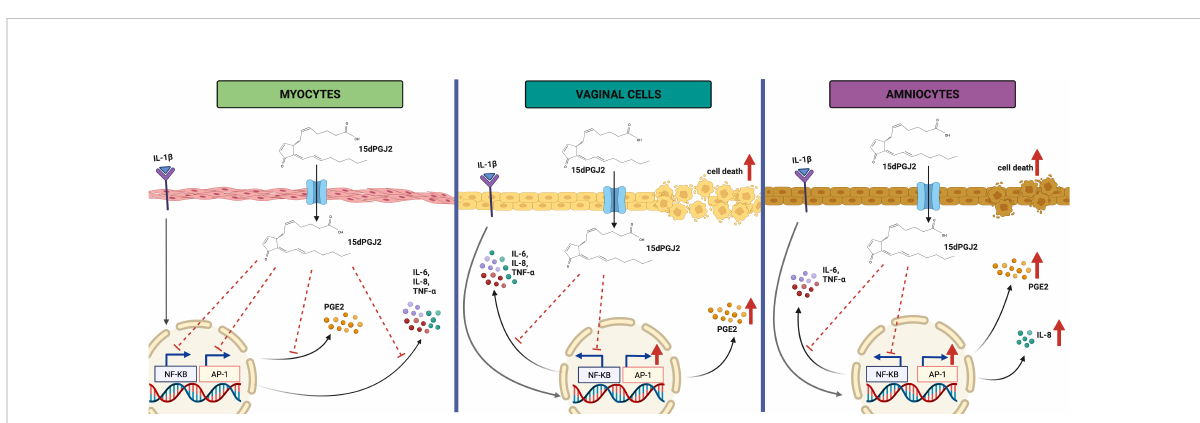
FIGURE 11 Illustration on the effect of IL-1 b and 15dPGJ2 on myocytes, vaginal and amnion epithelial cells. Pre-incubation of 15dPGJ2 in myocytes for 2 hours inhibited IL-1 b induced activation of the transcription factors NF- k B and AP-1. This led to inhibition of cytokine expression and PGE2 production. In VECs and AECs, 15dPGJ2 inhibited IL-1 b -stimulated NF- k B but led to activation of AP-1. A downstream inhibition of the pro- labour cytokines IL-6, IL-8, and TNF- a was seen in VECs. In contrast upregulation of IL-8 was seen in AECs. PGE2 production was increased both VECs and AECs following treatment with 15dPGJ2, and this may be due to AP-1 activation. In addition, increased cell death was seen in VECs and AECs with 15dPGJ2 treatment. We conclude that 15dPGJ2 has differential effects depending on cell type, and due to its ability